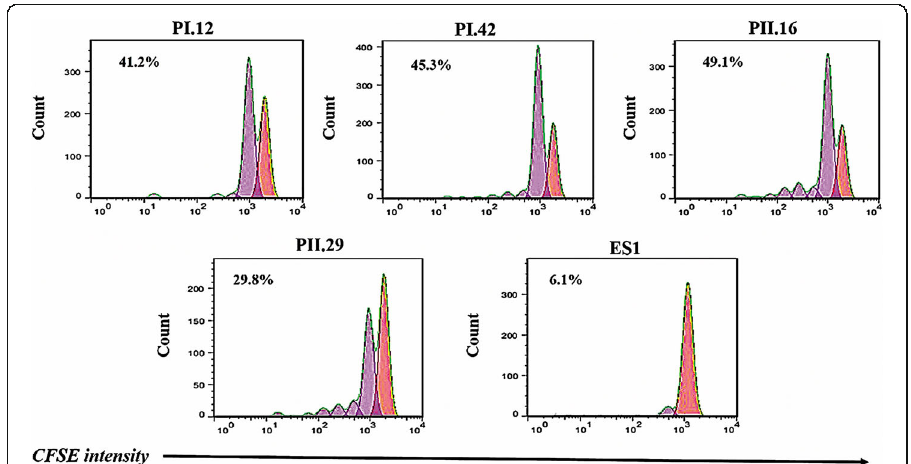
Fig. 4 Induction of cell division by anti-4-1BB scFvs. To measure cell division, purified T cells were labeled with CFSE and treated as described in the Materials and Methods section. After 72 h of treatment, the T cells were stained with CD3 and analyzed for CFSE levels via flow cytometry. Representative data show the % division and are representative of three independent experiments. The decrease in the mean fluorescence intensity of the CFSE-labeled cells was observed in cells treated with anti-4-1BB scFvs, which indicates that cell division had taken place. No division was observed in cells treated with ES1 and control ( p <